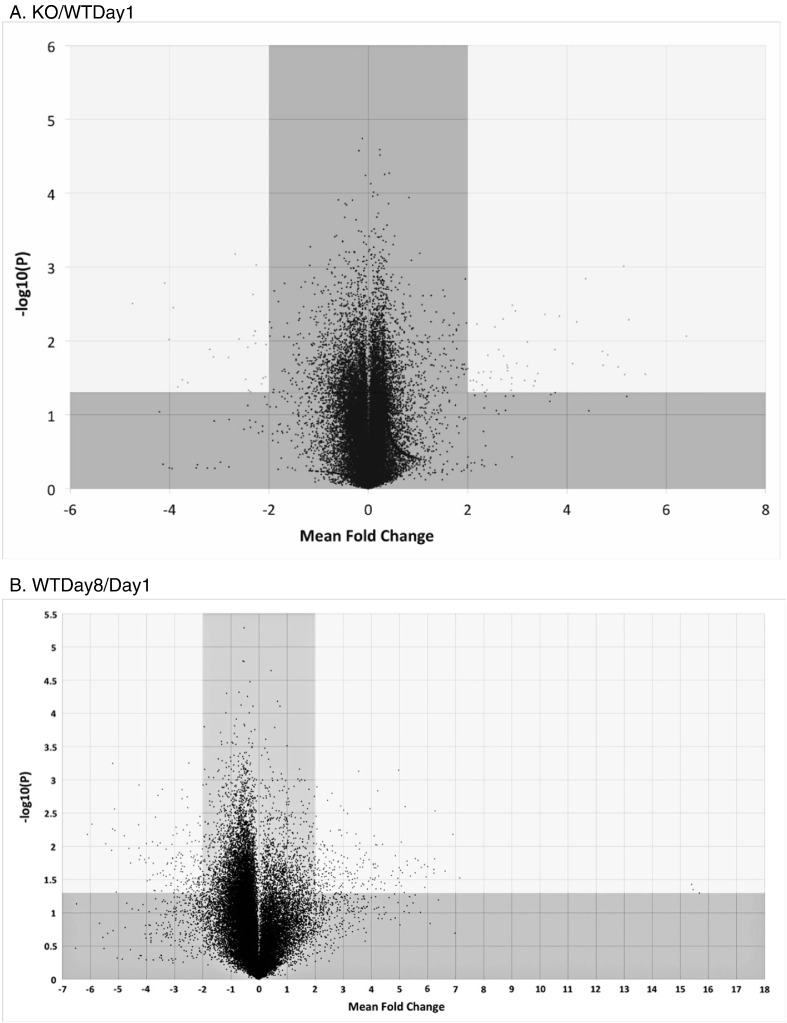
Overview of the four transcriptome signal comparisons: A. KO/WT Day1, B. WT Day 8/Day 1, C. KO/WT Day 8 and D. KO Day 8/Day 1. Volcano-plots display mean fold change (x-axis) vs. Statistical Significance (− log10(p-value)) (y-axis) for mRNA transcript signals. Experimentally significant probe signals shown within green regions were defined as having a mean fold change of >|2 |, and a p-value of < 0.05 (where − log10(P) = 1.301). Shaded regions indicate mRNA signals not meeting significance criteria. Note that the axes of Figs. B and D are different from Figs. A and C to accommodate the few out-lying values.